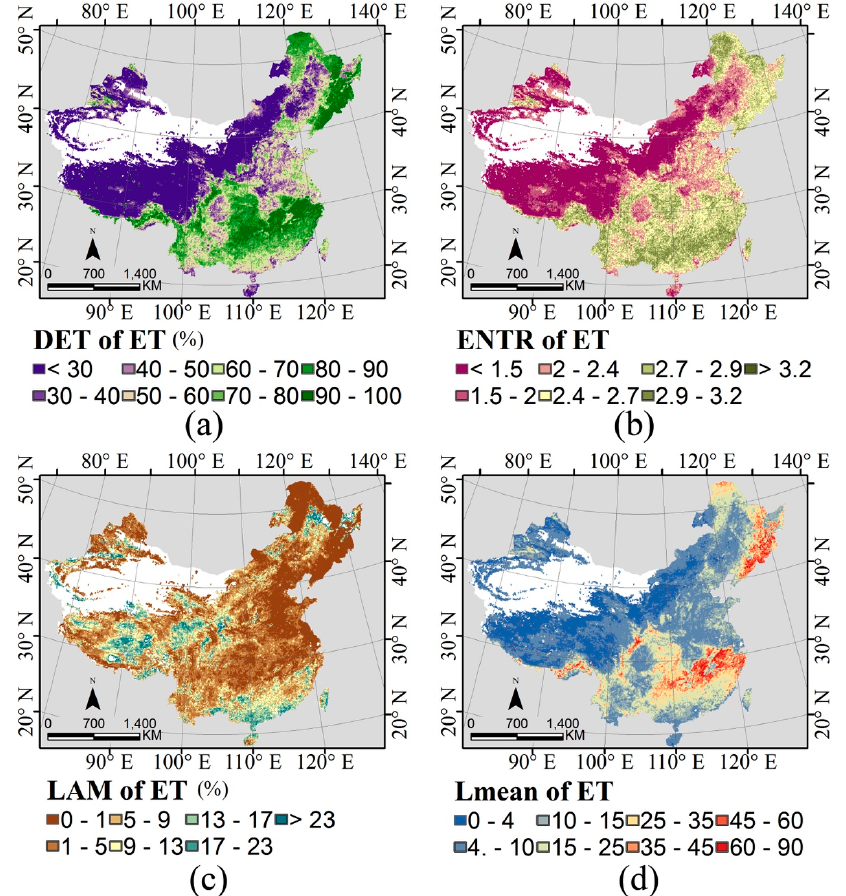
Figure 4. Geographical distribution of the temporal stability indices (based on monthly datasets from 2000 to 2013) of long-term evapotranspiration (ET): ( a ) determinism (DET); ( b ) Shannon entropy (ENTR); ( c ) laminarity (LAM); and ( d ) average diagonal line length (Lmean). These indices were generated using the CRT Toolbox for Matlab by Norbert Marwan [25] with the embedding dimensions: m = 6 and time delay τ = 2. The 10% of the maximum phase space diameter was chosen as the threshold ε for each pixel.